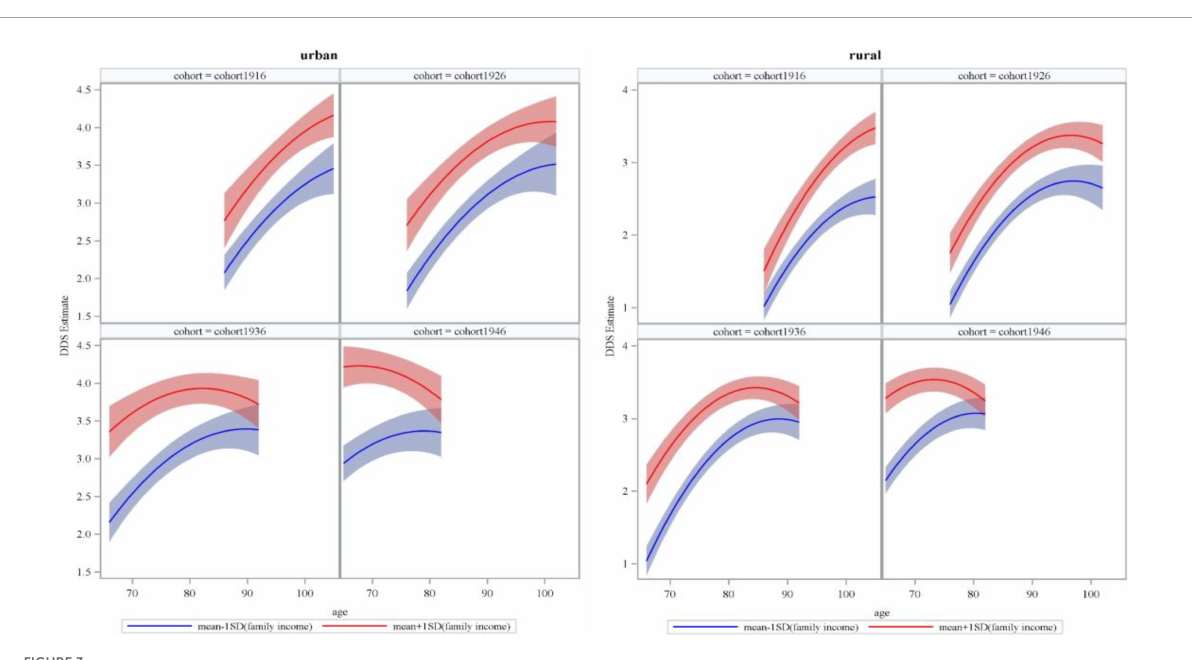
to the finding of Xu and Jiang’s study (42). They found that the